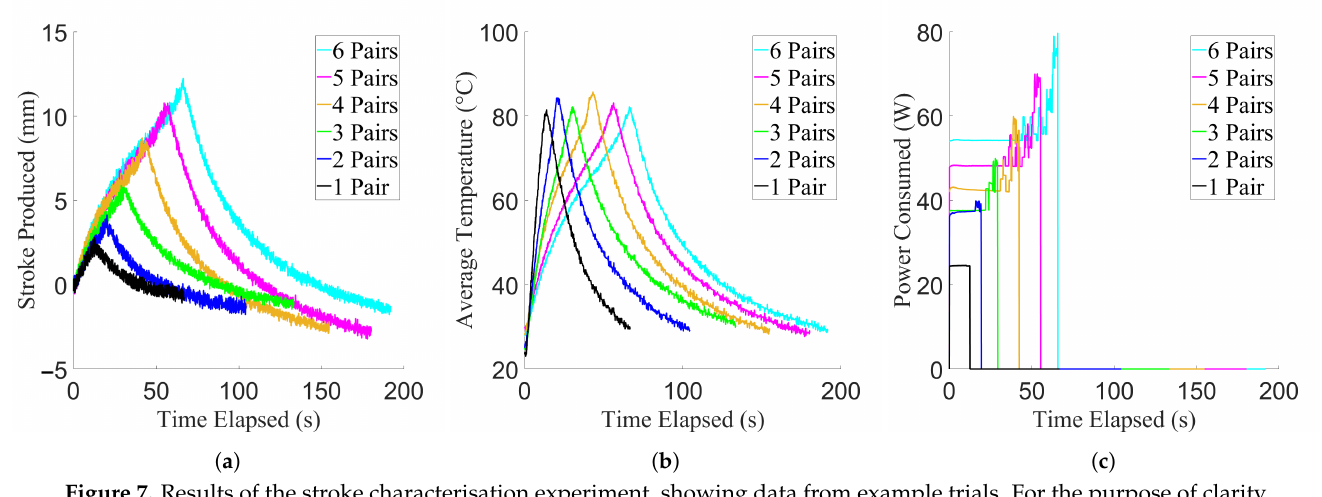
Figure 7. Results of the stroke characterisation experiment, showing data from example trials. For the purpose of clarity, example curves were used, due to low variance between trials. ( a ) Stroke production of the actuator. ( b ) Temperature achieved by the actuator. ( c ) Power consumed by the actuator.